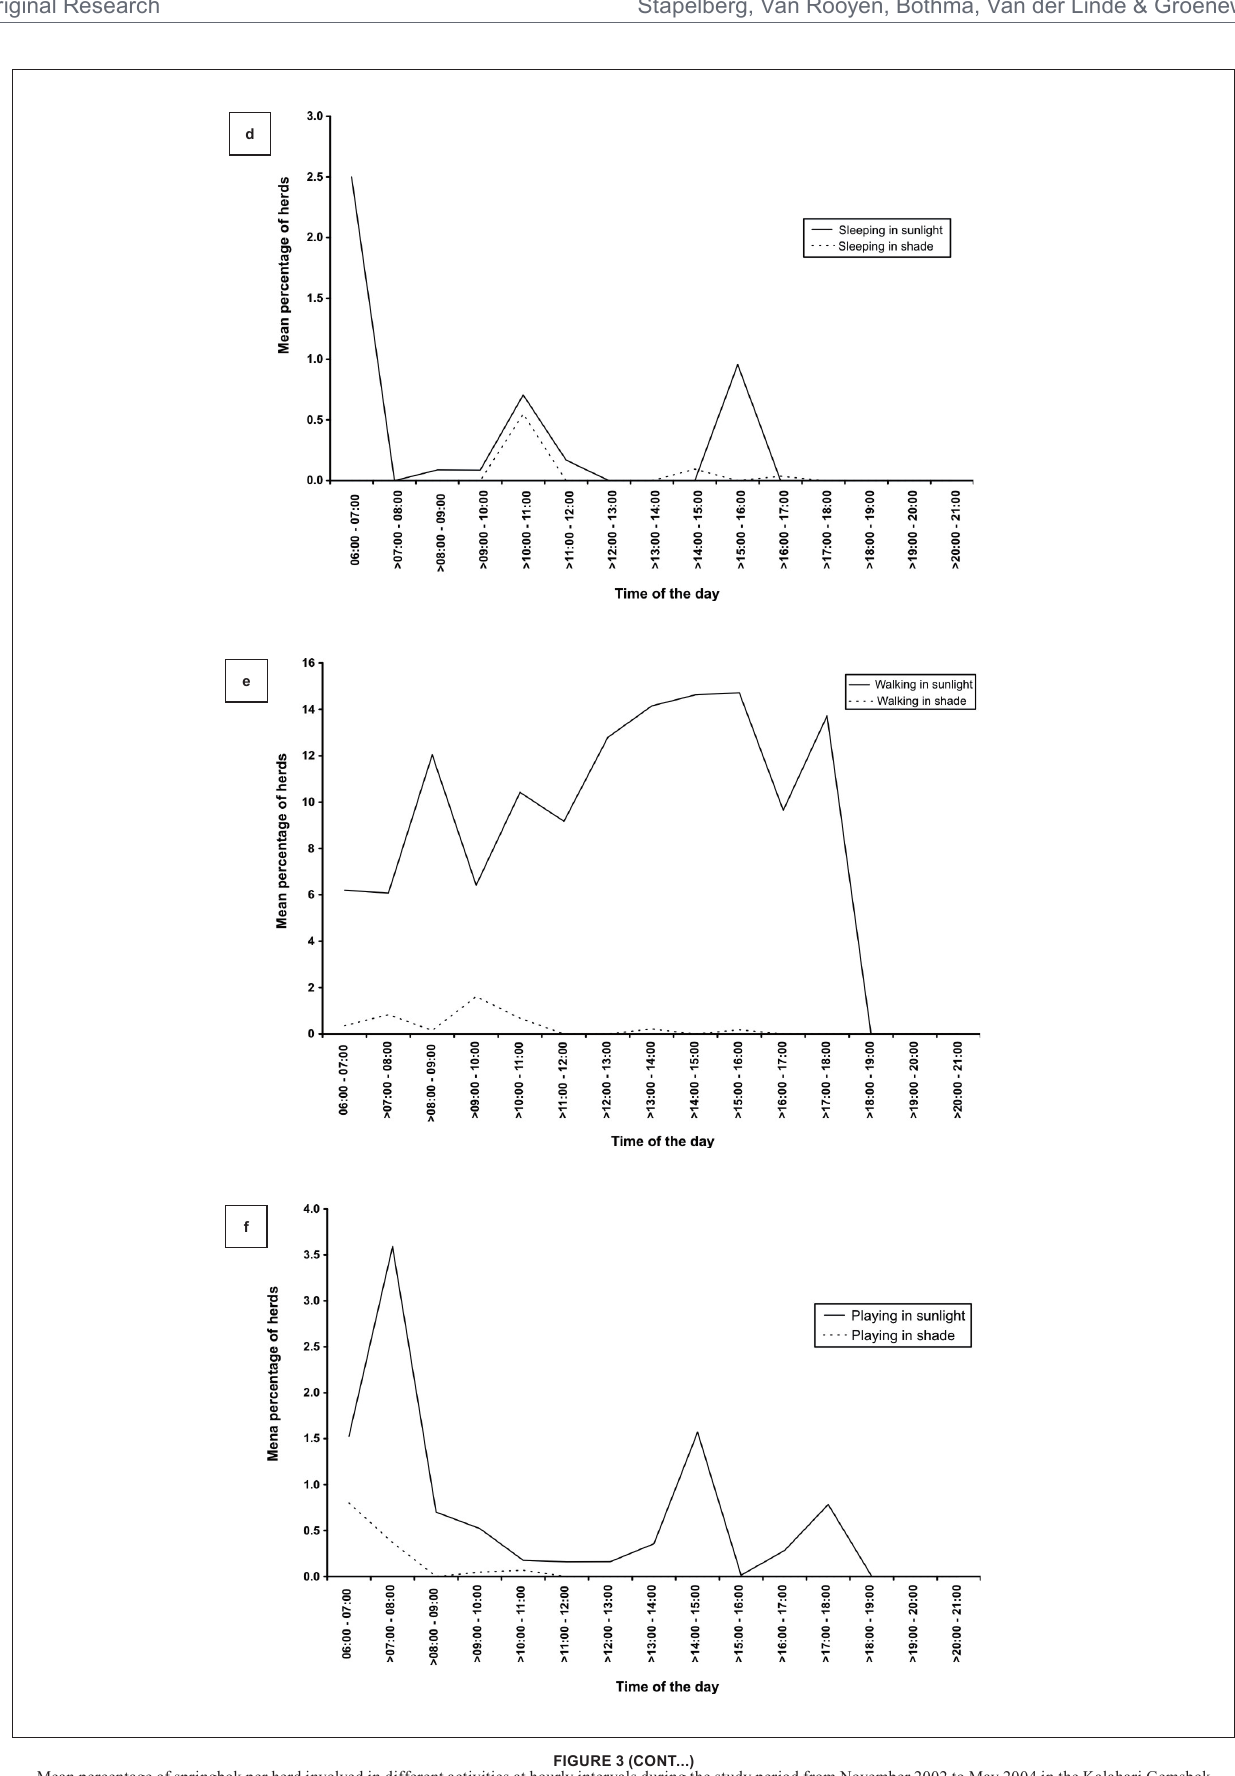
Figure 3 (conT...) Mean percentage of springbok per herd involved in different activities at hourly intervals during the study period from November 2002 to May 2004 in the Kalahari Gemsbok National Park: (d) sleeping in sunlight and shade, (e) walking in sunlight and shade, and (f) playing in sunlight and